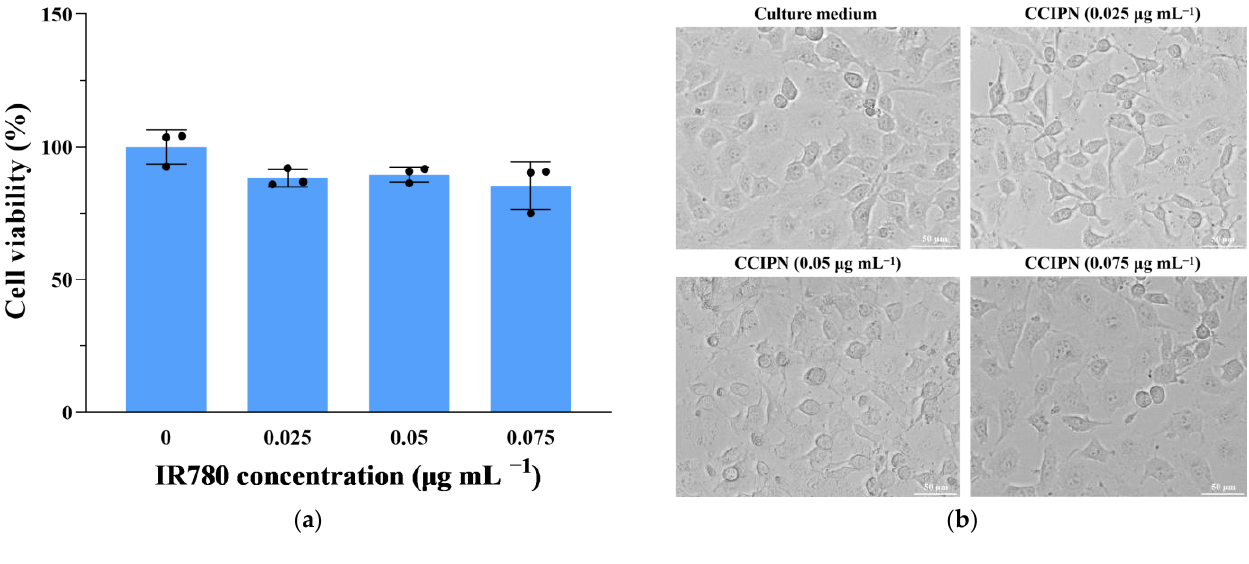
Figure 8. ( a ) Viability of HUVECs after incubation with various concentrations of CCIPNs (IR780 concentration 0, 0.025, 0.05 and 0.075 μg mL − 1 ) for 24 h in the dark. ( b ) Morphologies of HUVECs after incubation with various concentrations of CCIPNs (IR780 concentration 0, 0.025, 0.05 and 0.075 μg mL − 1 ) for 24 h in the dark. Values are expressed as mean ± SD (n = 3). Each dot represents an independent experiment.